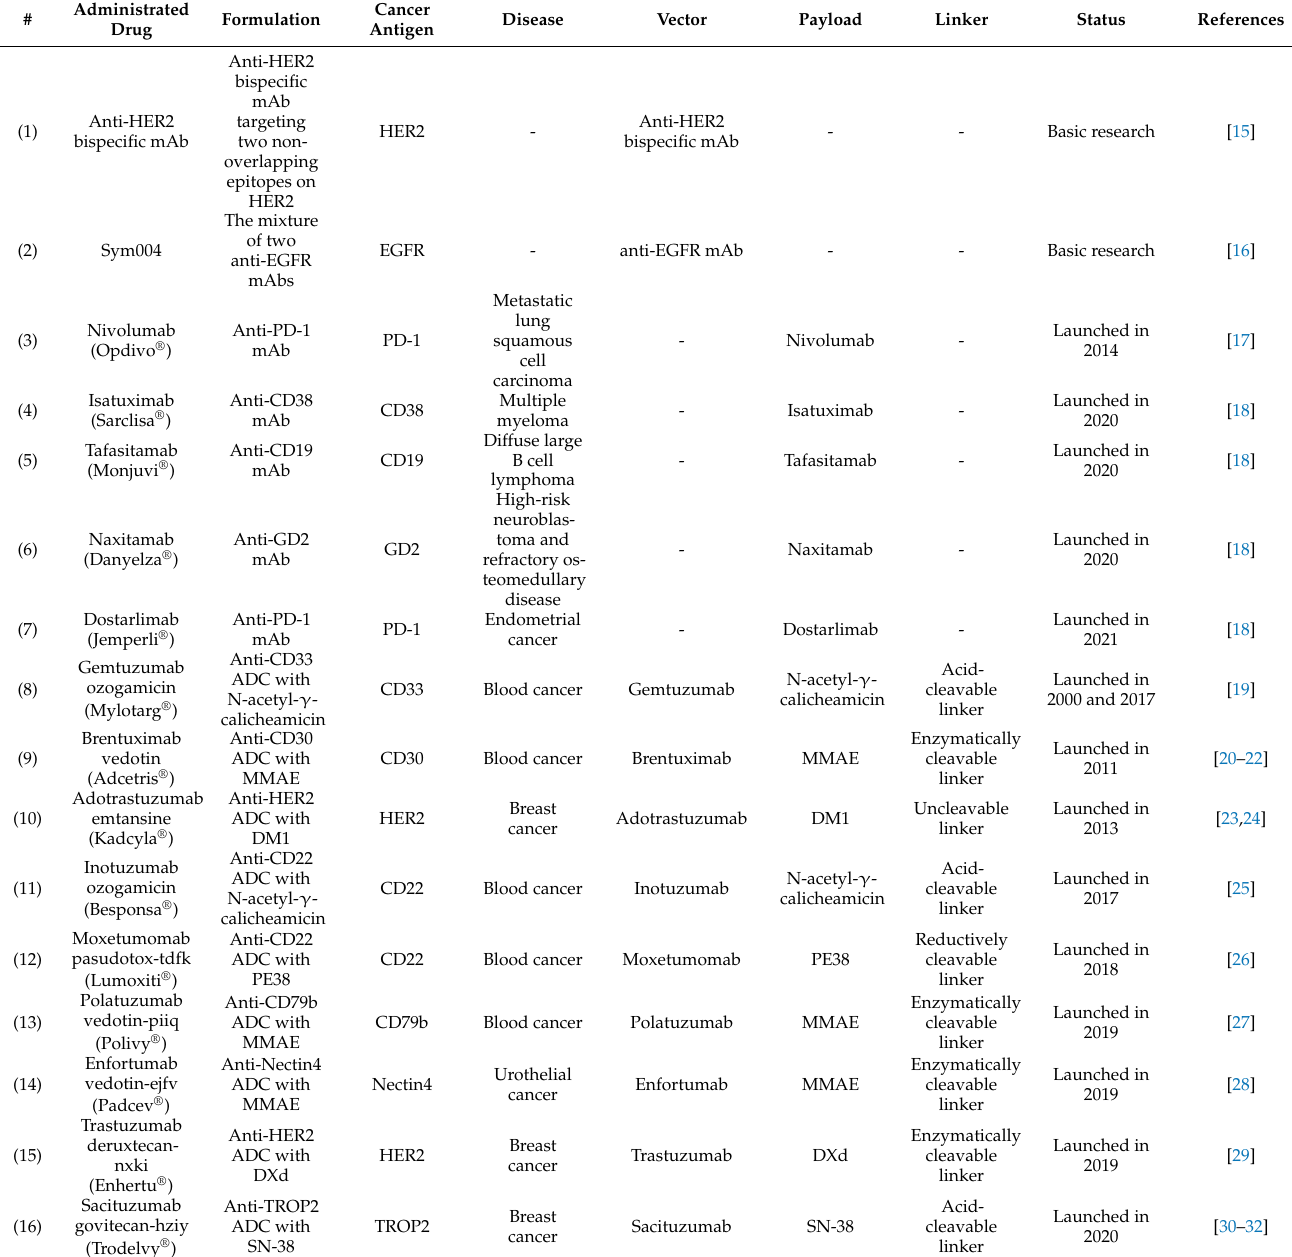
Table 1. All compounds introduced in this perspective